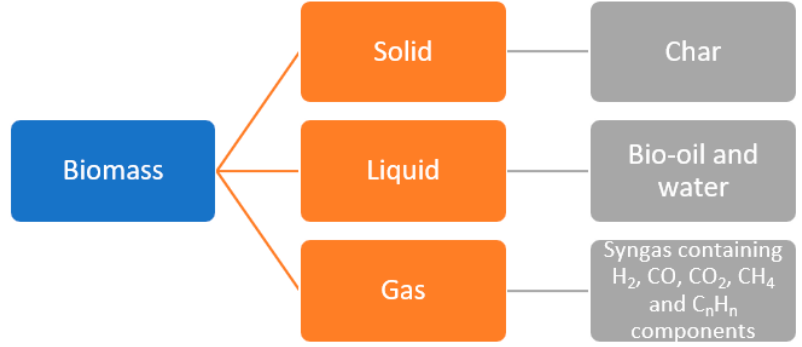
Figure 2. Biomass pyrolysis products (Adapted from [10]) .